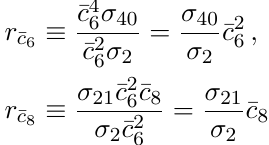
Figure 24 . (cid:22) c 6 -dependence of r (cid:22) c at di(cid:11)erent